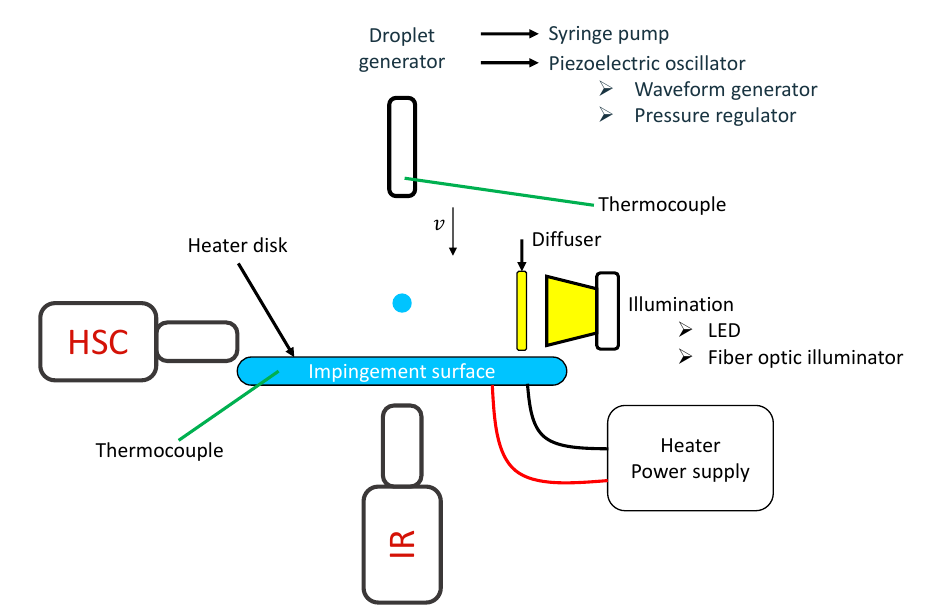
Figure 7. Typical experimental setup for dynamic droplet characterization with possible modifi- cations. High speed camera (HSC) records images at high speed to analyze droplet behavior at the impact and the Infrared thermal camera (IR) is used to measure the surface temperature for thermal